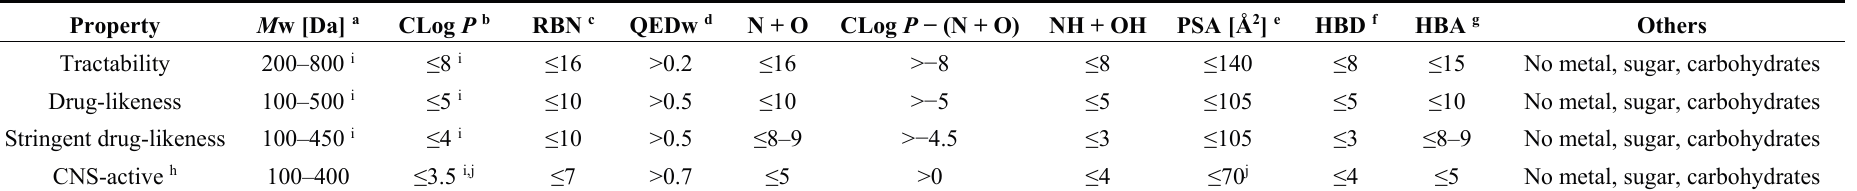
Table 4. Summary of physicochemical and physiochemical descriptors selected for every